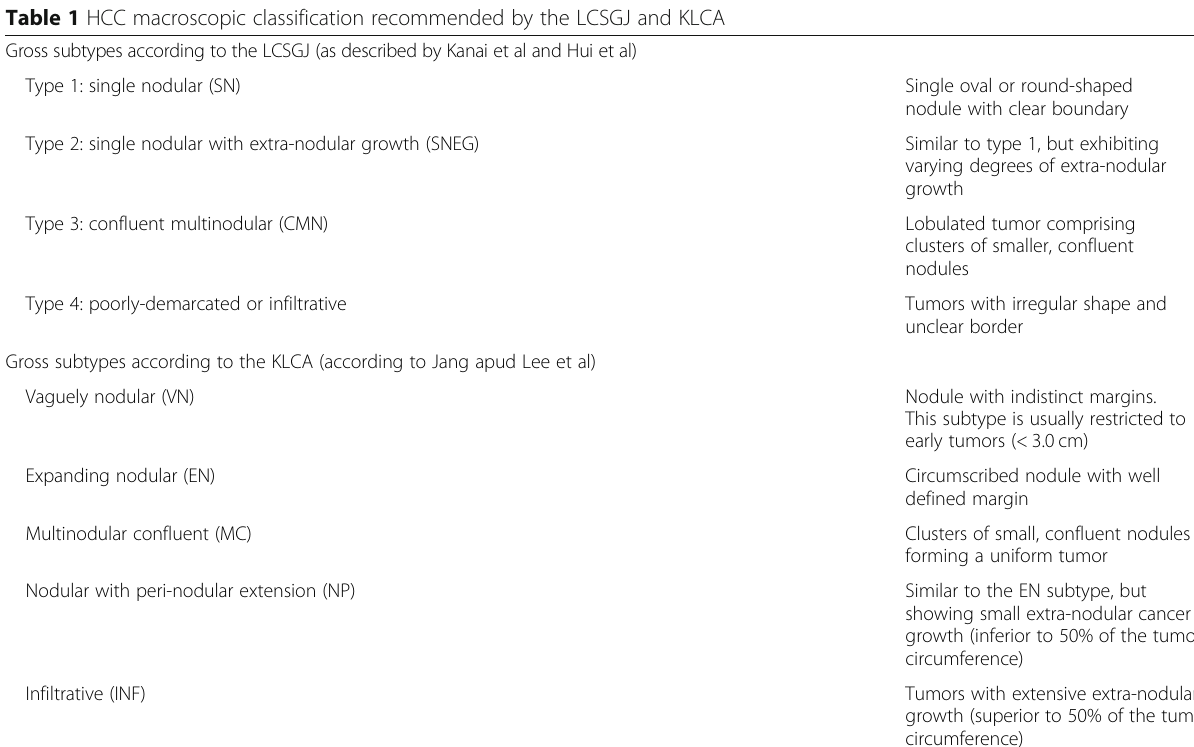
Table 1 HCC macroscopic classification recommended by the LCSGJ and KLCA Gross subtypes according to the LCSGJ (as described by Kanai et al and Hui et al) Type 1: single nodular (SN) Single oval or round-shaped